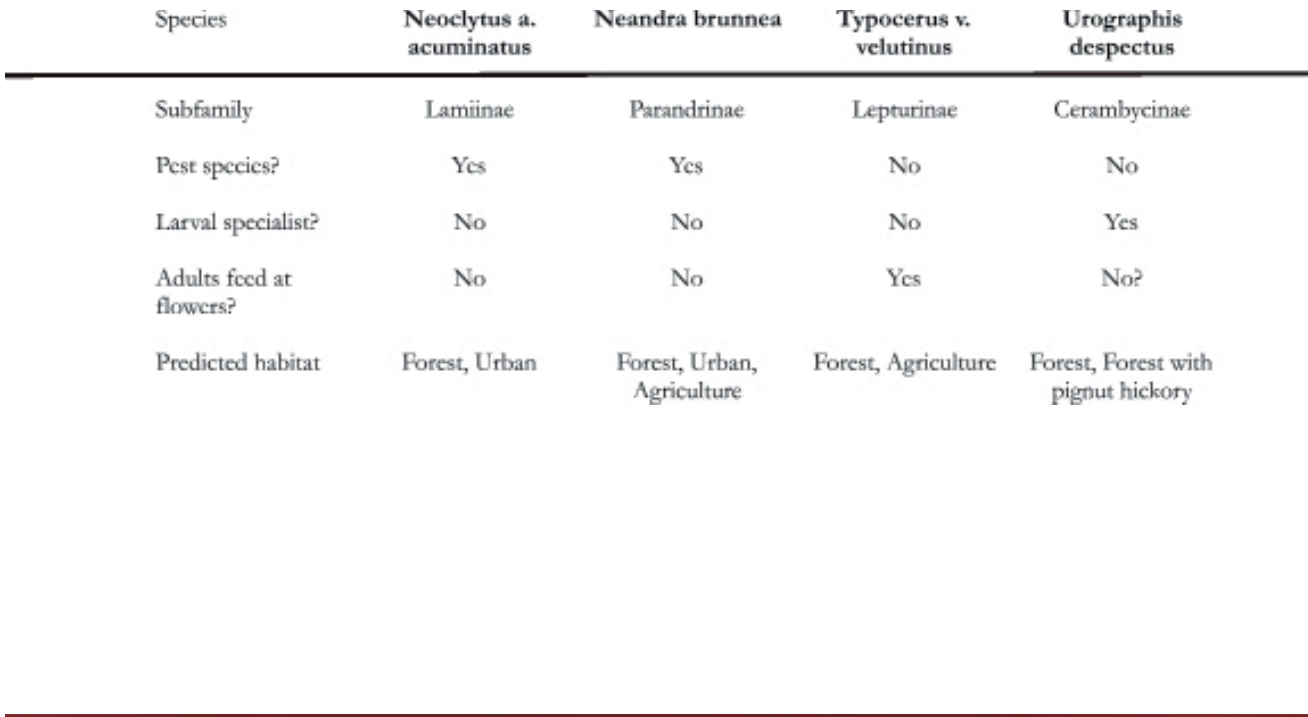
Table 1. Biological attributes of the four study species of longhorned